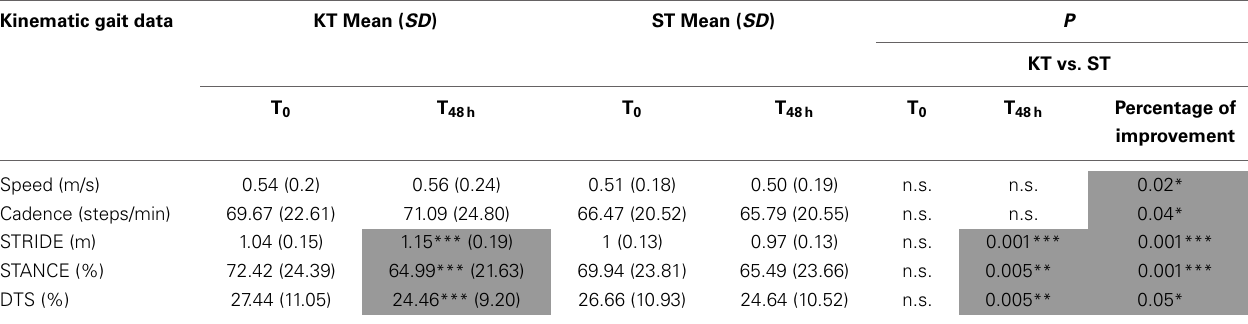
Table 4 | Gait assessment.